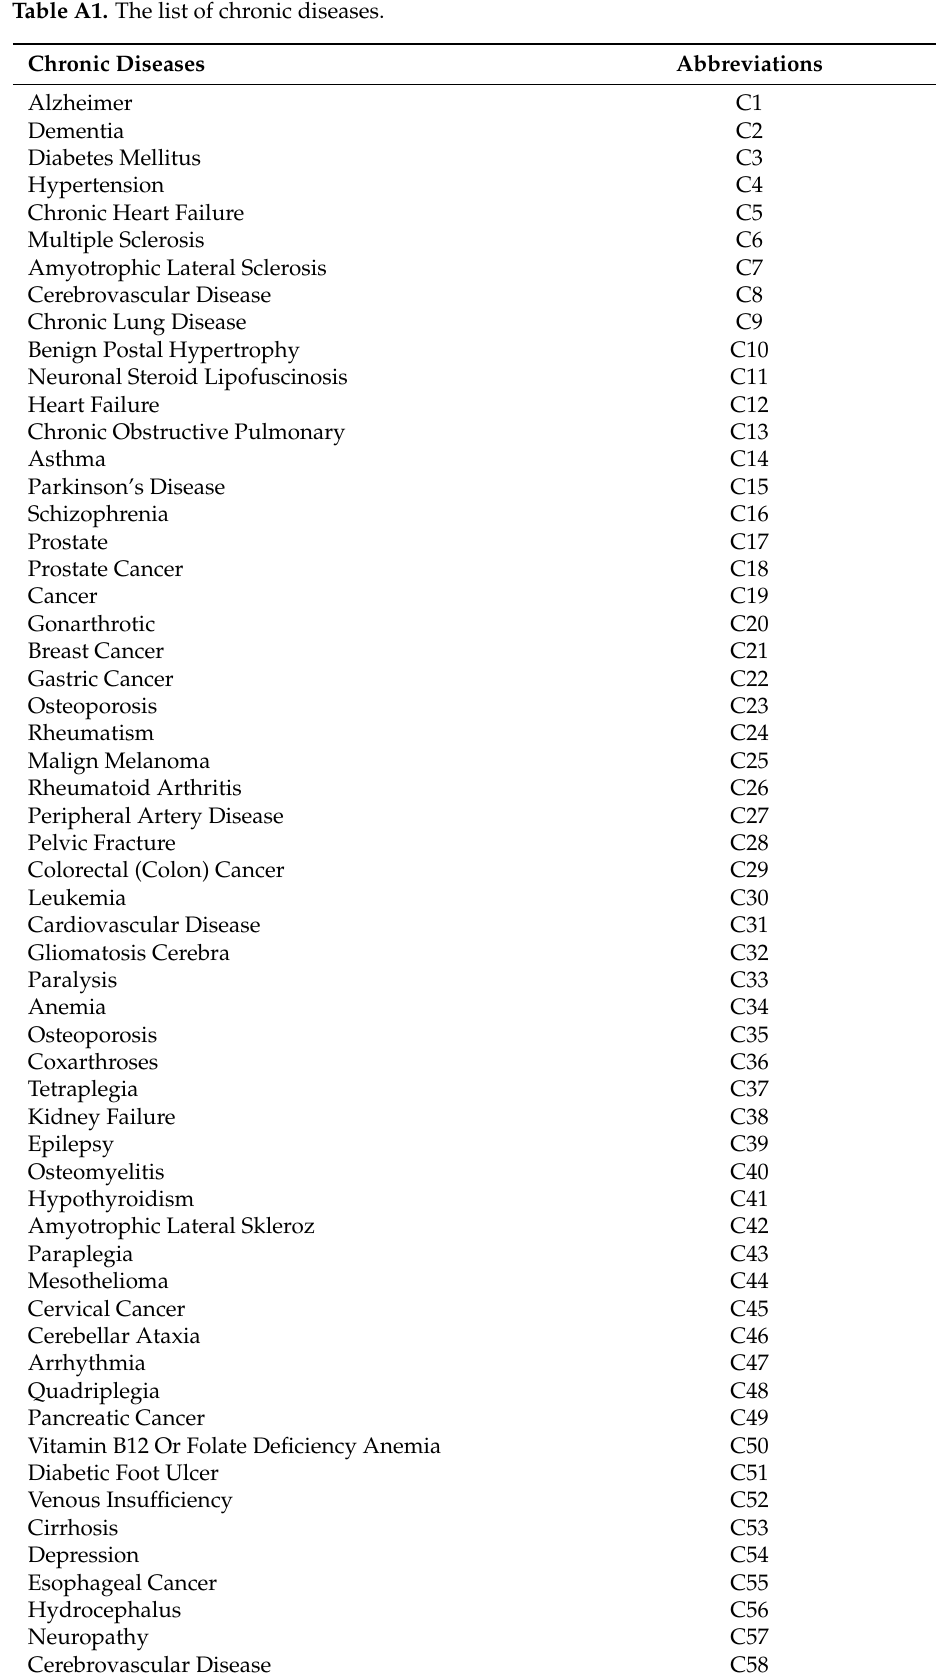
Table A1. The list of chronic